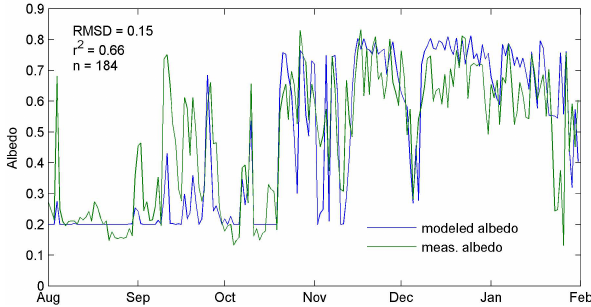
Fig. 2. Comparison of daily mean measured surface albedo with modeled surface albedo computed with optimized albedo model pa- rameters. RMSD is the root mean square deviation, r 2 the coeffi- cient of determination and n is the number of considered days. To exclude the effects of surface slope on albedo measurements, only hourly values with solar zenith angle above 60 ◦ were considered for calculating the daily means.